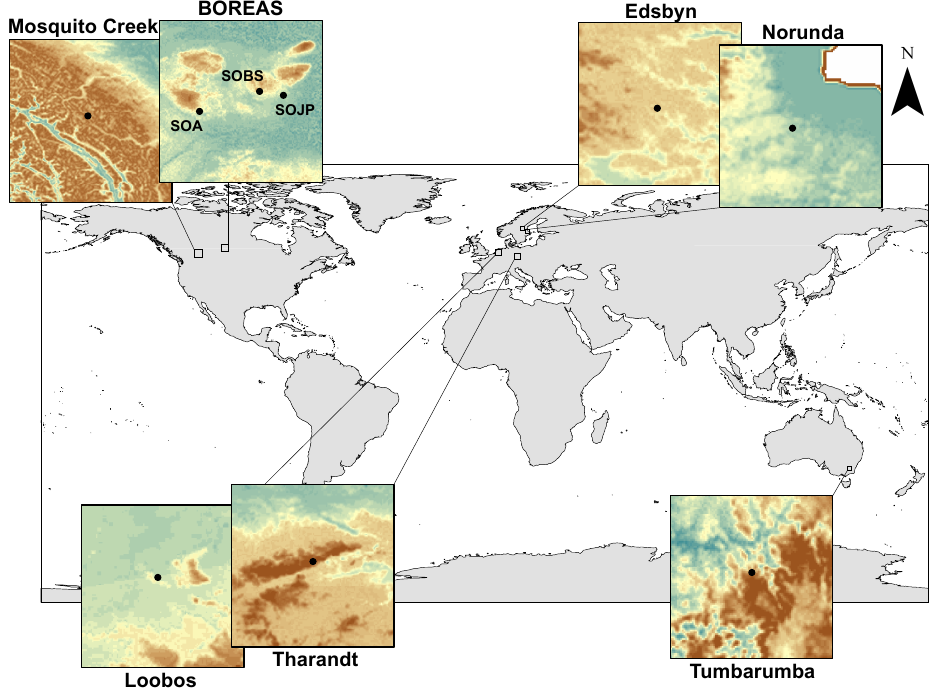
Figure 2. Map of all sites employed in this study. Local relief at each site is illustrated in respective panes (source: Natural Earth). Note: each panel highlights broad-scale terrain characteristics at each site, and as a result, elevation range varies with site; sit-specific elevation ranges are given in Table